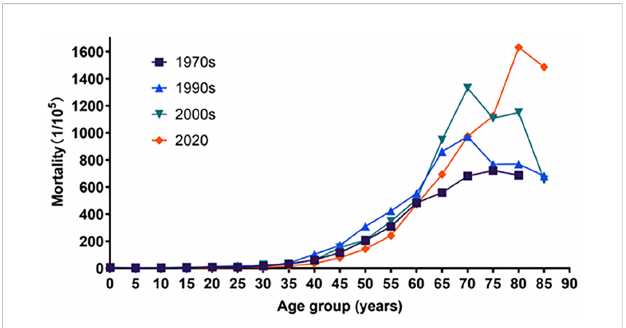
FIGURE 5 Age-speci fi c mortality rates and trends of cancer, trends of Chi-square of the fi rst time, the second time, the third time, and 2020 were 47,628.486, 5,696.633, 6,482.973, and 0957.890, respectively. All P- values were less than